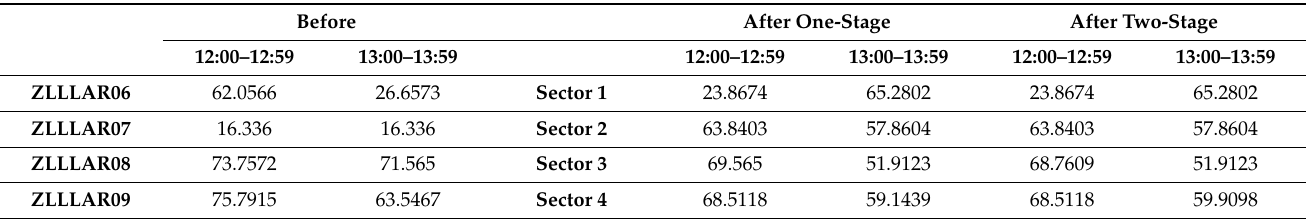
Table 8. 12:00–13:59 Workload values for each sector before and after